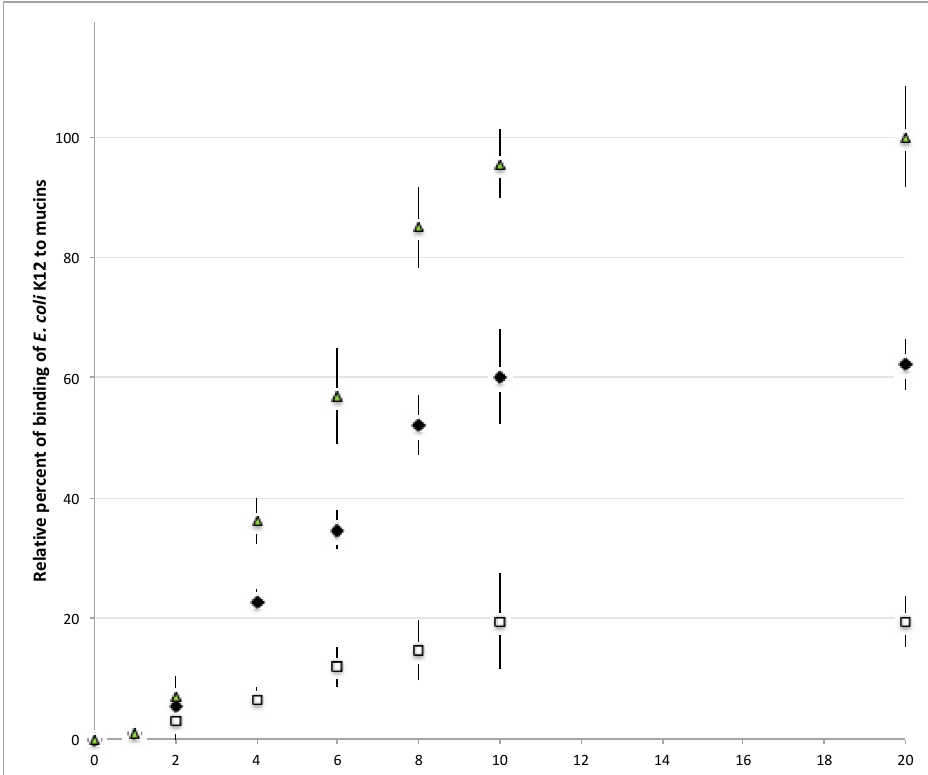
Figure 2. Relationship between the intensity of fluorescence and the number of mucins spotted. Mucins from the human colon ( ∆ ), jejunum ( ) and ileum ( ) were spotted at different quantities on nitrocellulose membrane and the signal of bound fluorescent-labeled E. coli K12 was quantified. Above 20 µg of mucins per spot of 9 mm 2 , the signal reaches a plateau.